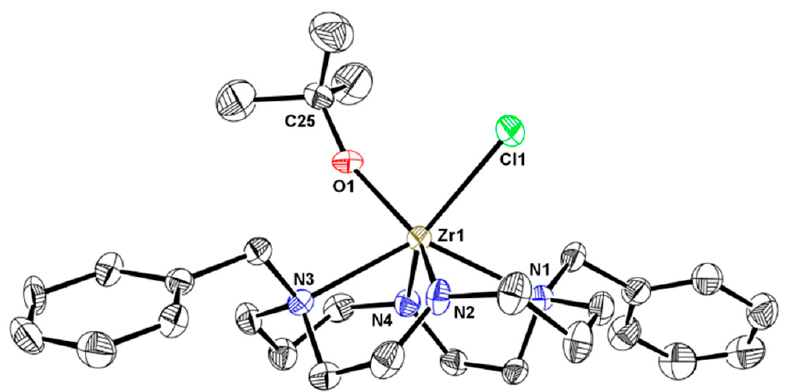
Figure 1. ORTEP diagram of 2 with thermal ellipsoids at 40% probability level. Hydrogen atoms are omitted for clarity. Selected bond lengths (Å) and angles (º): Zr(1)-Cl(1) 2.528(2), Zr(1)-O(1) 1.958(4), Zr(1)-N(1) 2.453(5), Zr(1)-N(2) 2.101(5), Zr(1)-N(3) 2.508(4), Zr(1)-N(4) 2.068(5); O(1)-Zr(1)-Cl(1) 87.0(1), Zr(1)-O(1)-C(25) 161.8(4).